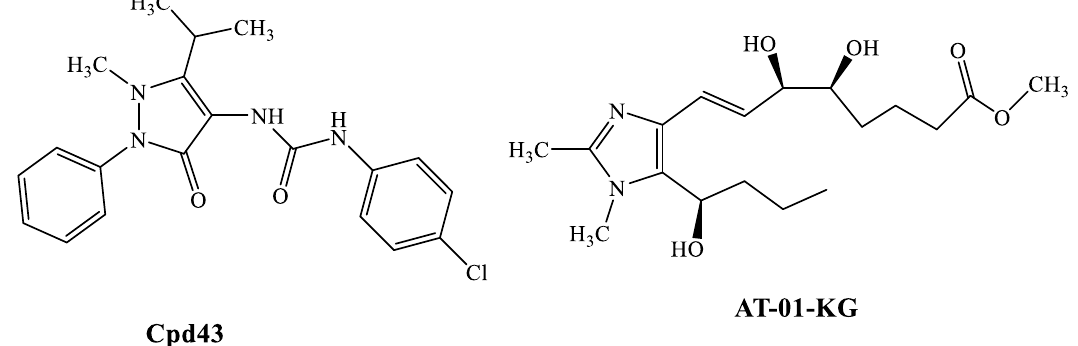
Figure 1. FPR agonists active in animal models of RA.